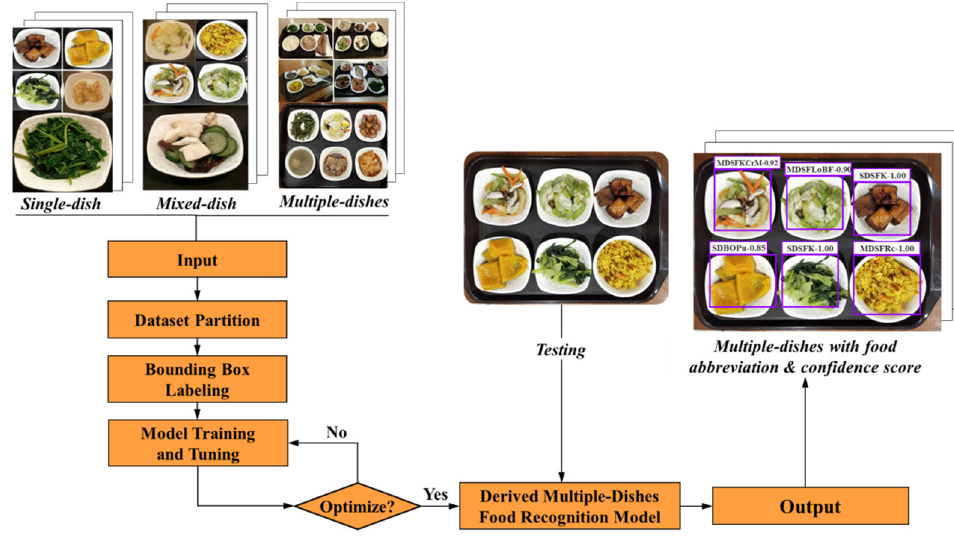
Figure 1. Proposed multiple-dish food recognition model